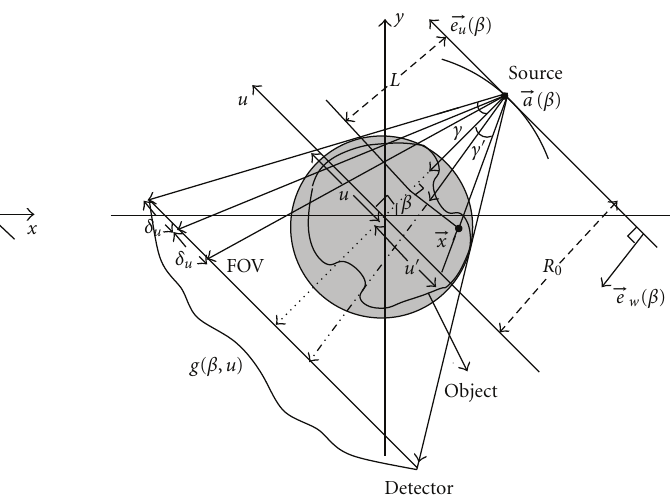
Figure 2: Relation between the fan-beam and parallel-beam geom- etry.